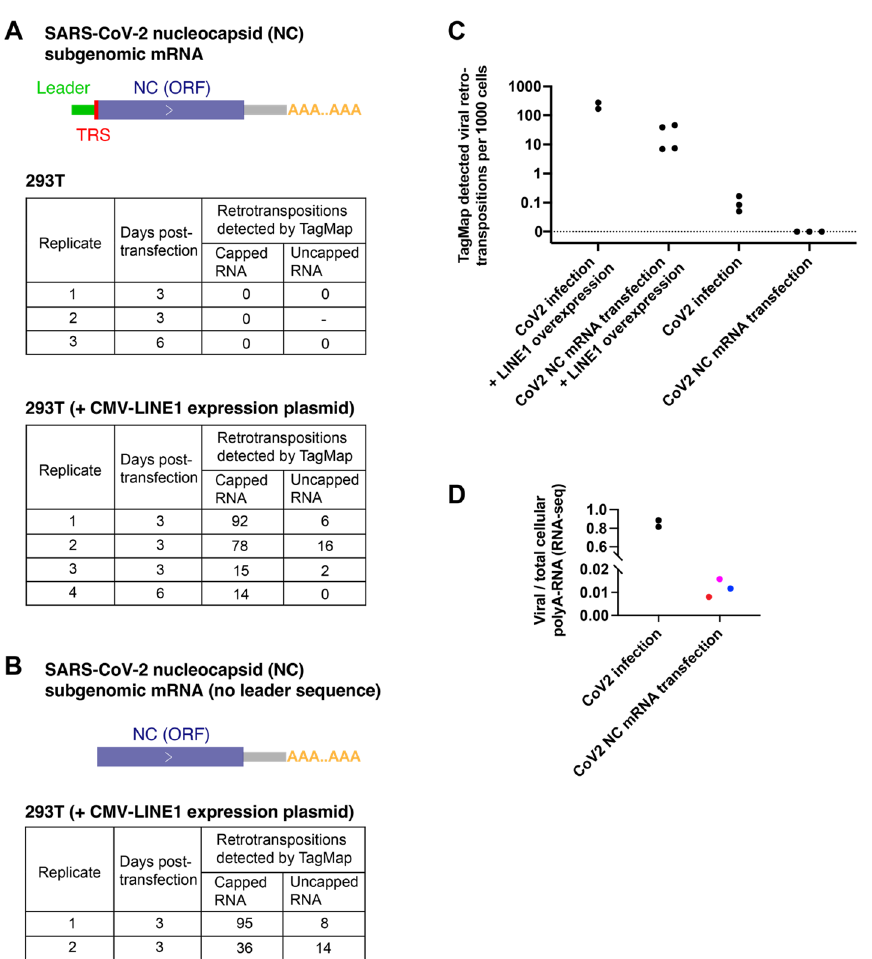
Figure 2. No retrotransposition events were detected by TagMap in cells transfected by viral nucleo- capsid mRNA alone. ( A , B ) Retrotranspositions detected by TagMap in 293T cells transfected with SARS-CoV-2 nucleocapsid (NC) subgenomic mRNA ( A ) with the leader sequence or ( B ) without the leader sequence, with or without LINE1 overexpression. 293T cells were transfected by the listed NC mRNA with a concentration of 1 µ g RNA per 1mL cell culture medium. For LINE1 overexpression, a CMV-LINE1 plasmid was co-transfected with the NC mRNA, with a concentration of 0.5 µ g or 1 µ g plasmid per 1 mL cell culture medium. The in vitro transcribed NC mRNA can either express or not express the encoded NC protein depending on whether or not the mRNA was 5 (cid:48) -capped, as listed in the tables. ( C ) Retrotransposition detected by TagMap in cells infected with SARS-CoV-2 or transfected with NC mRNA, with or without LINE1 overexpression. CoV2 infection + LINE1 overexpression: 678 or 1110 retrotransposition events were detected in ~4000 293T cells (Table 1). CoV2 NC mRNA (5 (cid:48) -capped) transfection + LINE1 overexpression: 14–92 retrotransposition events were detected in ~2000 293T cells ( A ). CoV2 infection: 1–2 retrotransposition events were detected in ~12,000–20,000 hESC-ACE2 or Calu3 cells (Table 1). CoV2 NC mRNA (5 (cid:48) -capped) transfection: No retrotransposition events were detected in ~20,000 293T cells (Figure 2A). ( D ) Fractions of viral poly-A RNA relative to total cellular poly-A RNA in cells infected with SARS-CoV-2 or in cells transfected with SARS-CoV-2 NC mRNA. For SARS-CoV-2 infected cells, Calu3 cell RNA was harvested 2 days post-infection; RNA-seq data were from a previous publication [27]. For cells transfected with NC mRNA, 293T cells cultured in 24-well plates were transfected by 0.5 µ g (red dot), 1 µ g (magenta dot), or 2 µ g (blue dot) RNA per 1mL cell culture medium for 6 h and then lysed for extraction of cellular RNA and poly-A RNA-seq using the same method that was used for infected